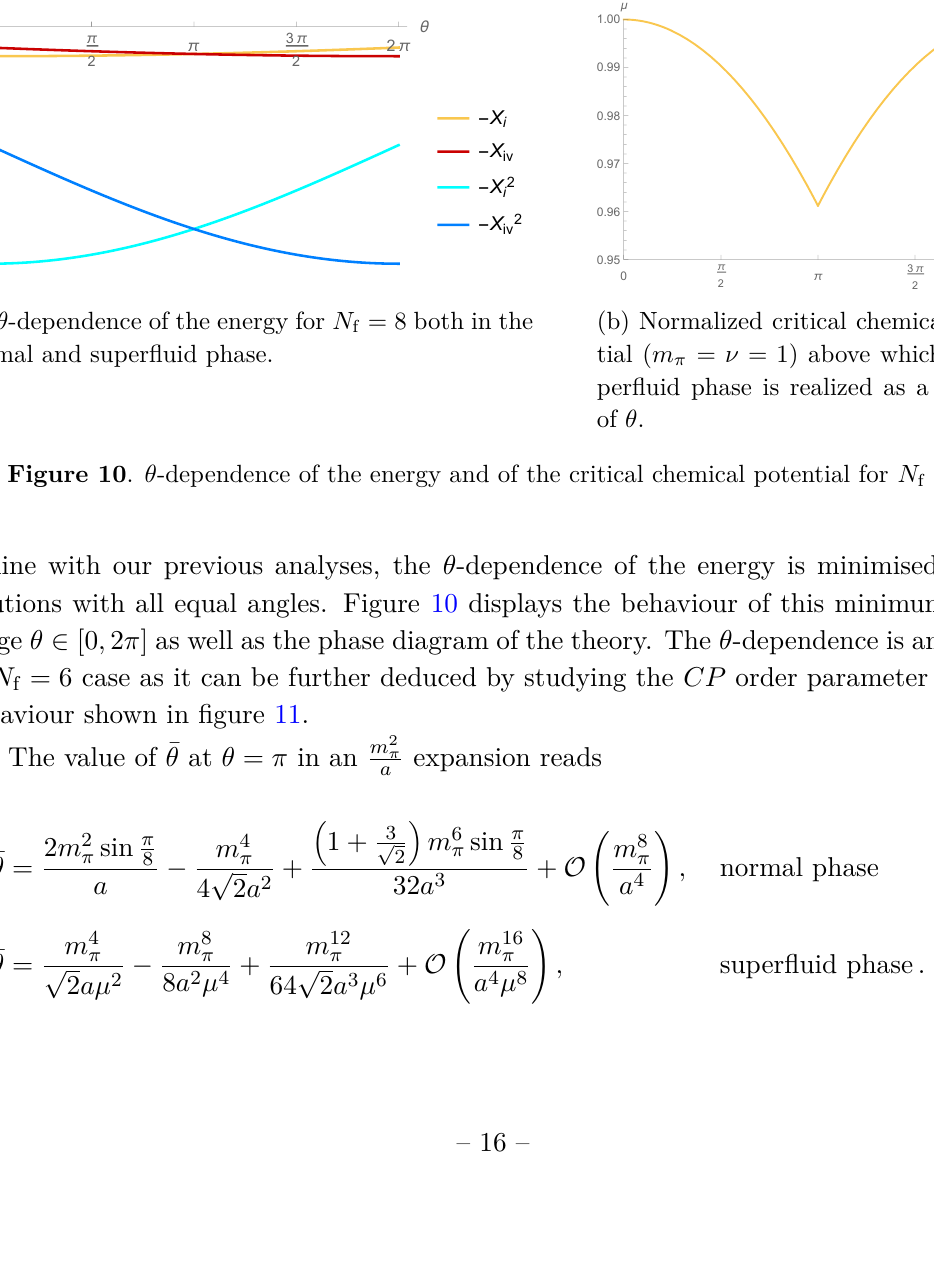
(b) The CP order parameter (cid:10) F ˜ F (cid:11) as a function of θ in the superfluid phase for different values of the chemical potential: µ = 5 , 10 , 15 . We consider m = ν = 1 . π